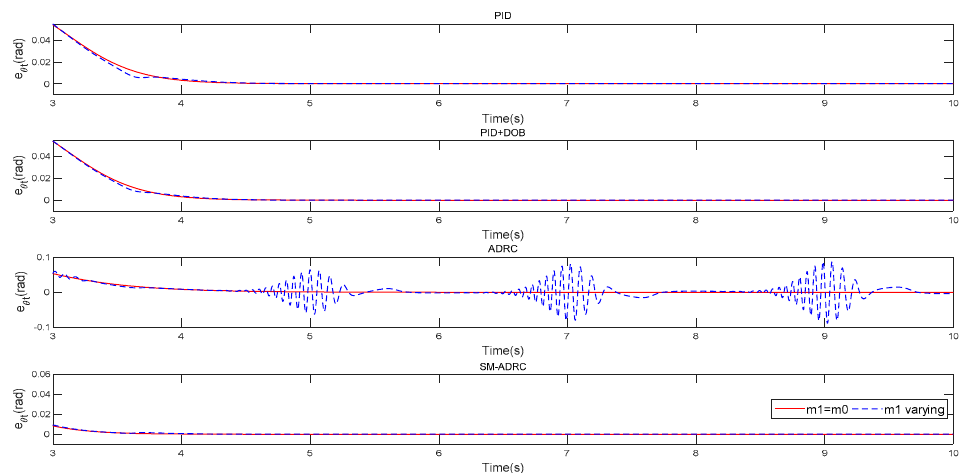
Figure 7. Tracking trajectories of the flexible manipulator tip position with the tip mass varying.